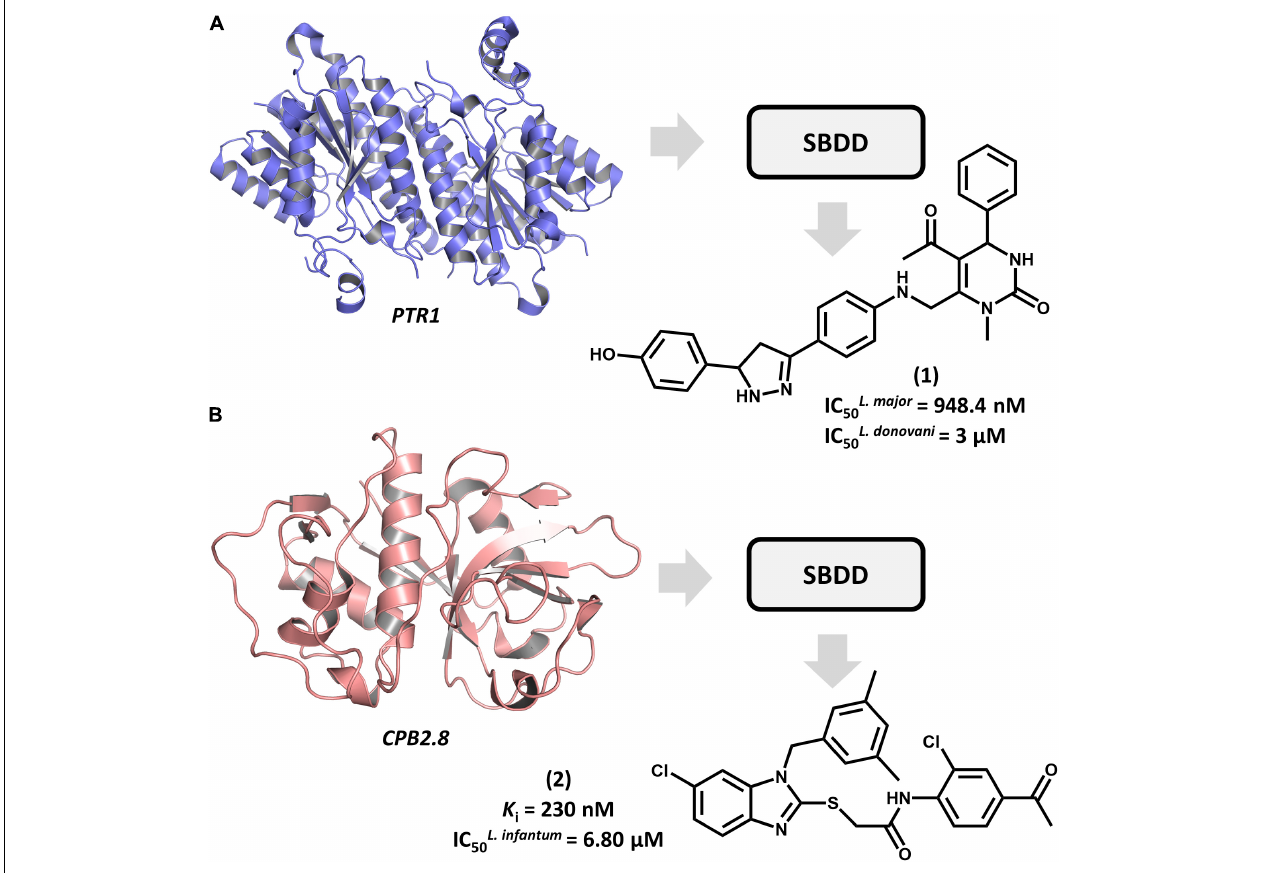
FIGURE 2 | SBDD in leishmaniasis drug discovery. (A) An SBDD approach using molecular docking on pteridine reductase 1 (PTR1) that led to the discovery of dihydropyrimidine 1 as a novel antileishmanial agent. (B) The design of the L. infantum cysteine-protease type 2 (CPB2.8) inhibitor 2 having antileishmanial activity.